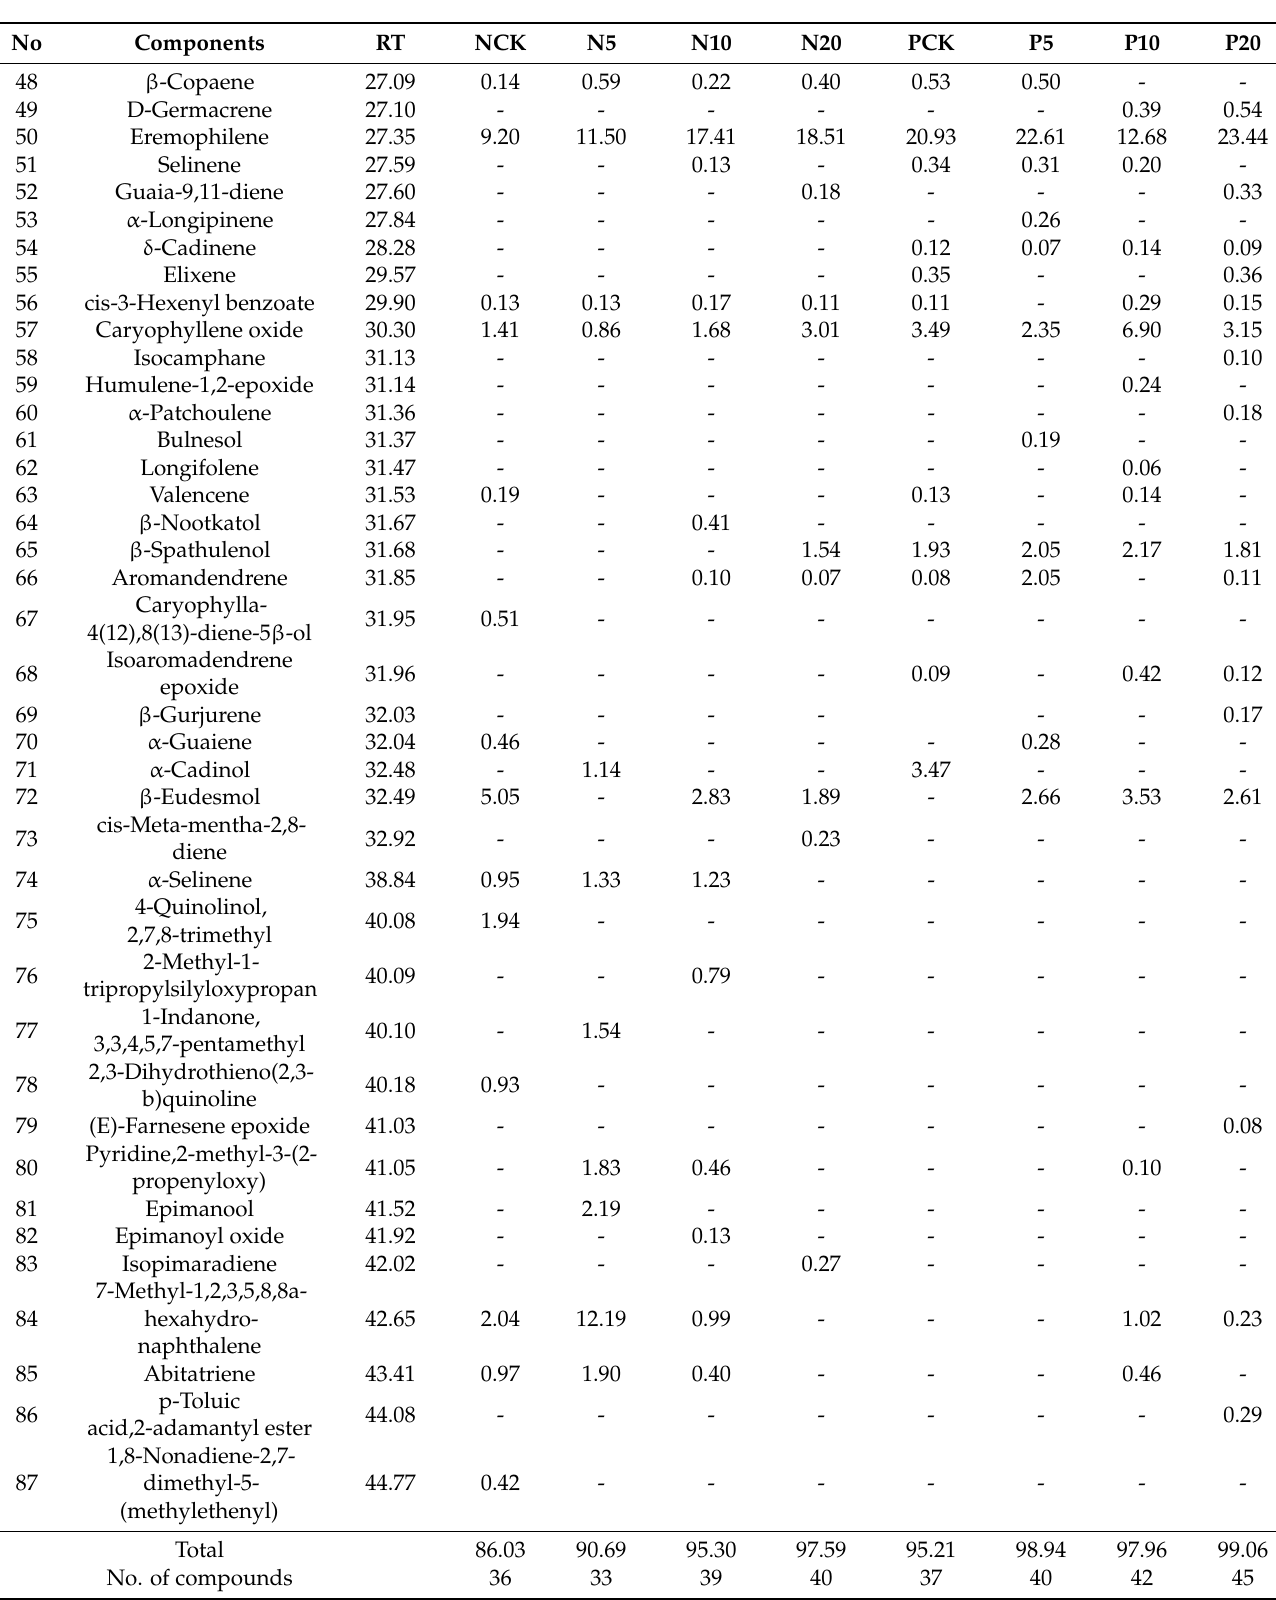
Percentage values are means of five analyses. RT: Retention time; -: Not